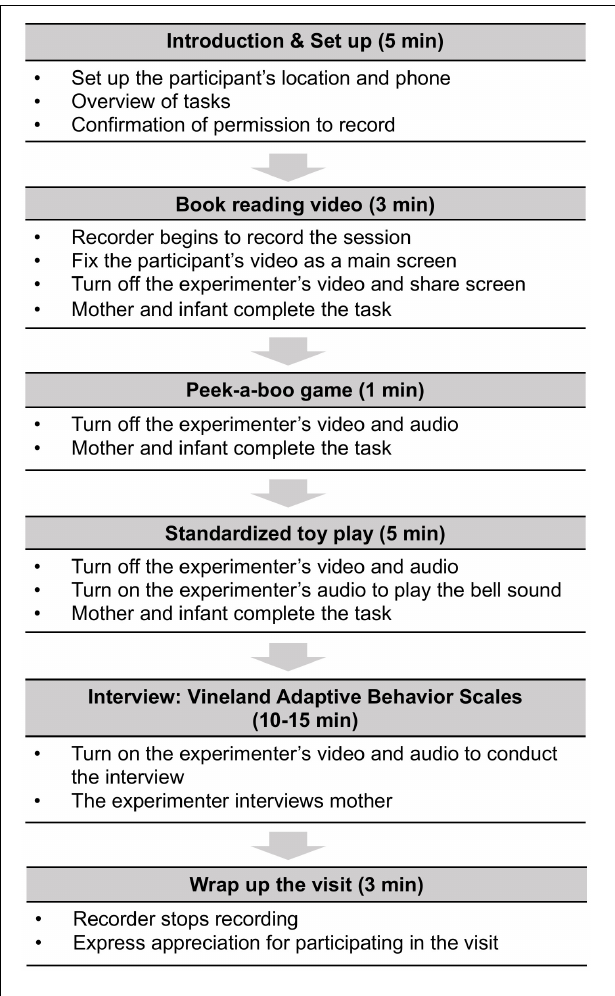
FIGURE 6 | Process of virtual